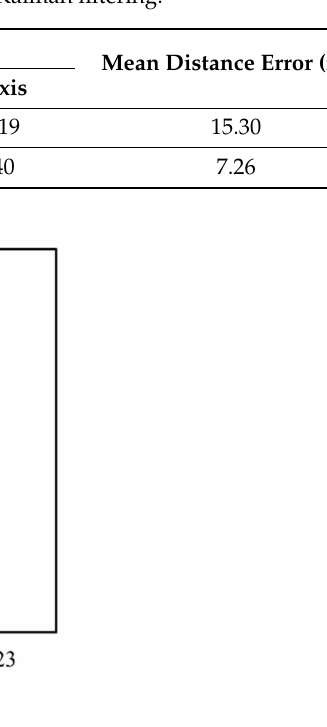
Figure 12. ( a ) ECG waveform in lead II constructed based on [16] and ( b ) multiple source localization corresponding to R-wave. Blue dots represent an ideal pathway. Red and green color vectors represent the estimated direction of electric dipole source at an elapsed time corresponding to OMP with and without Kalman filtering, respectively. Table 5. Localization performance error with and without Kalman filtering.